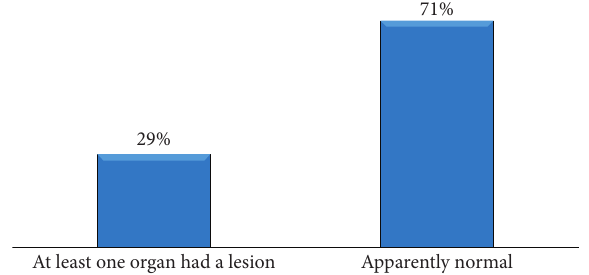
Figure 2: Overall animal-level pathological lesion prevalences in she-camels’ reproductive